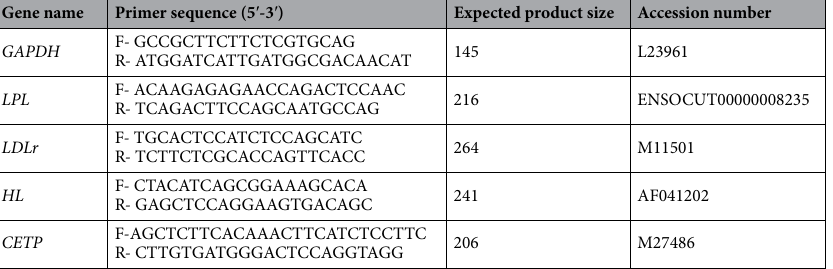
Table 3. Primers used for qRT-PCR. GAPDH refers to Glyceraldehyde 3-phosphate dehydrogenase, LPL refers to Lipoprotein lipase, LDLr refers to low-density lipoprotein receptor, HL refers to hepatic lipase, and CETP refer to Cholesteryl ester transfer